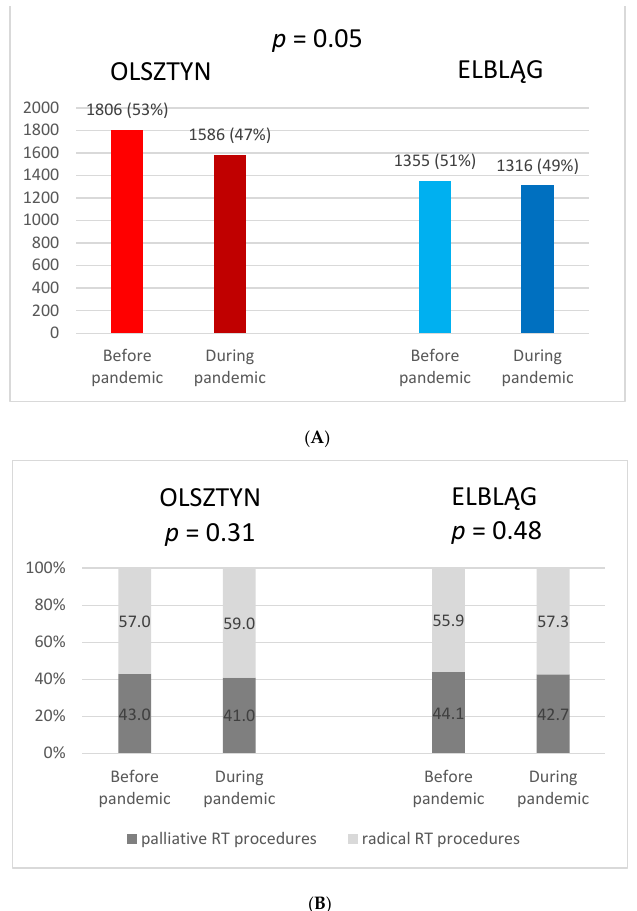
Figure 1. Comparison of radiotherapy procedures before and during the pandemic between Olsztyn and Elbląg ( A ). Comparison of percentage of RT procedures due to radical and palliative intention in Olsztyn and Elbląg ( B ).